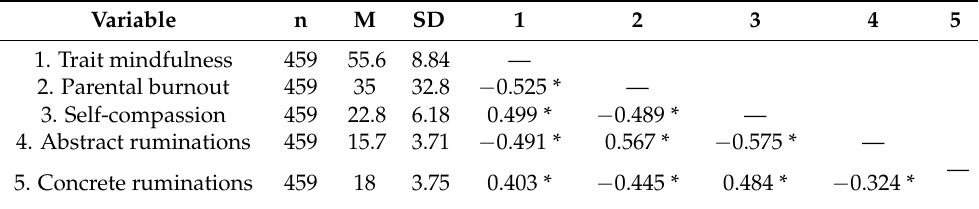
Table 2. Descriptive statistics and correlations (Pearson’s r) among the study variables at Time